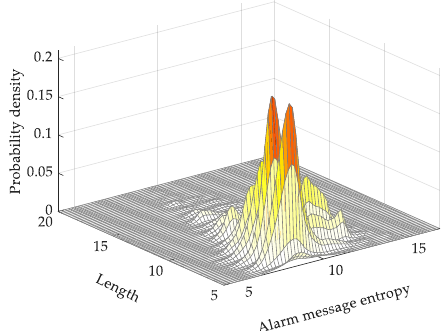
Figure 9. Probability density map of average relative alarm-message entropy.